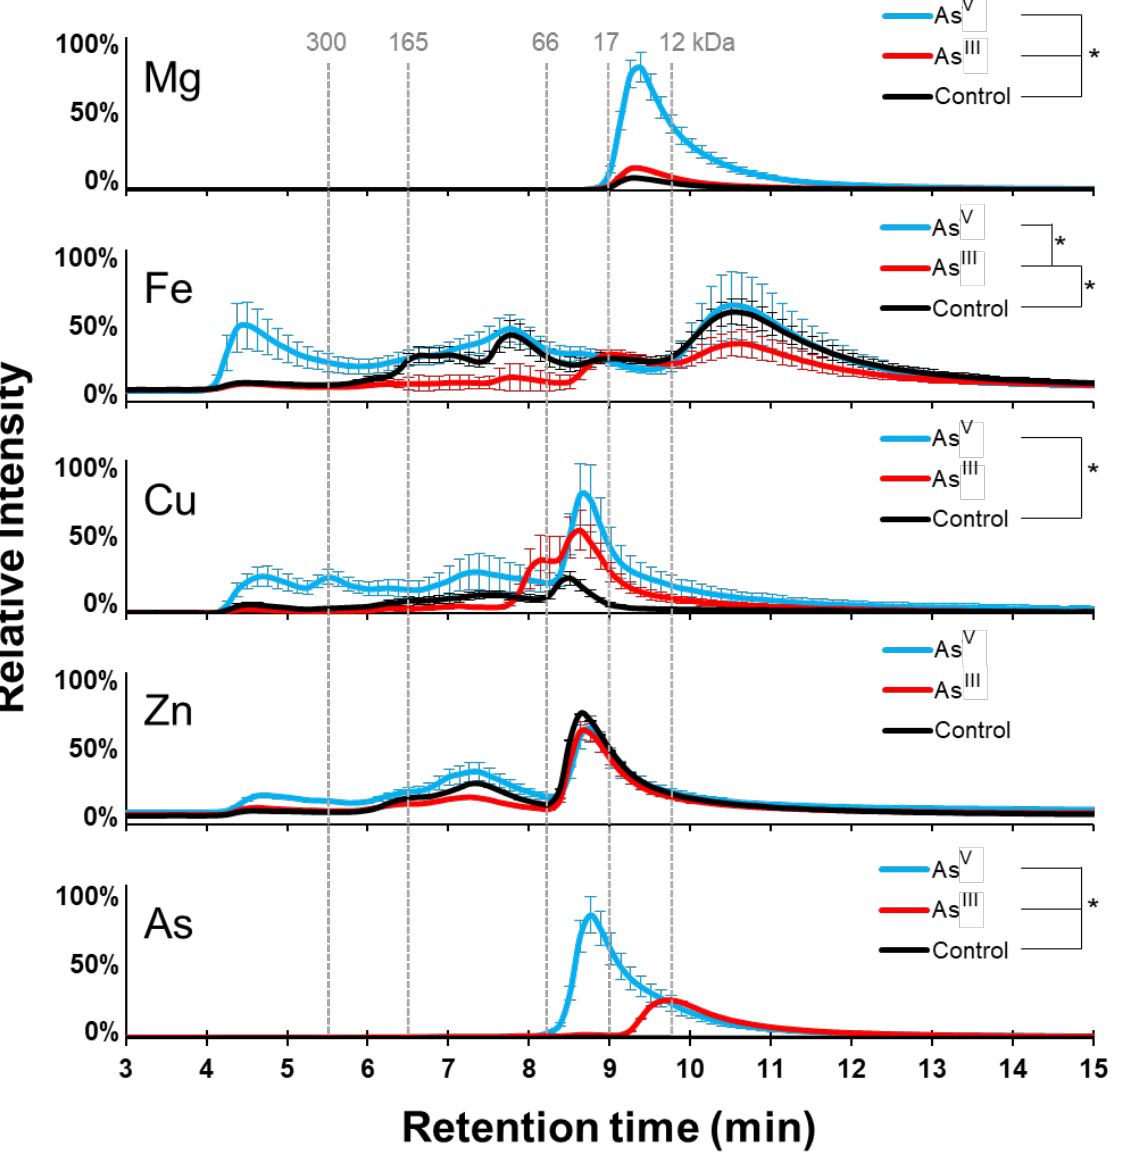
Figure 2. K-12 metalloproteome response to arsenic treatment. SEC-ICP-MS analysis shows the size distribution of protein-bound copper, magnesium, arsenic, iron, and zinc. As V treatment is shown in cyan, the As III treatment in red, and the control in black. Error bars are +/ − 1 standard deviation. * Indicates significant differences ( p < 0.05) determined by a Student’s t -test (n = 3).